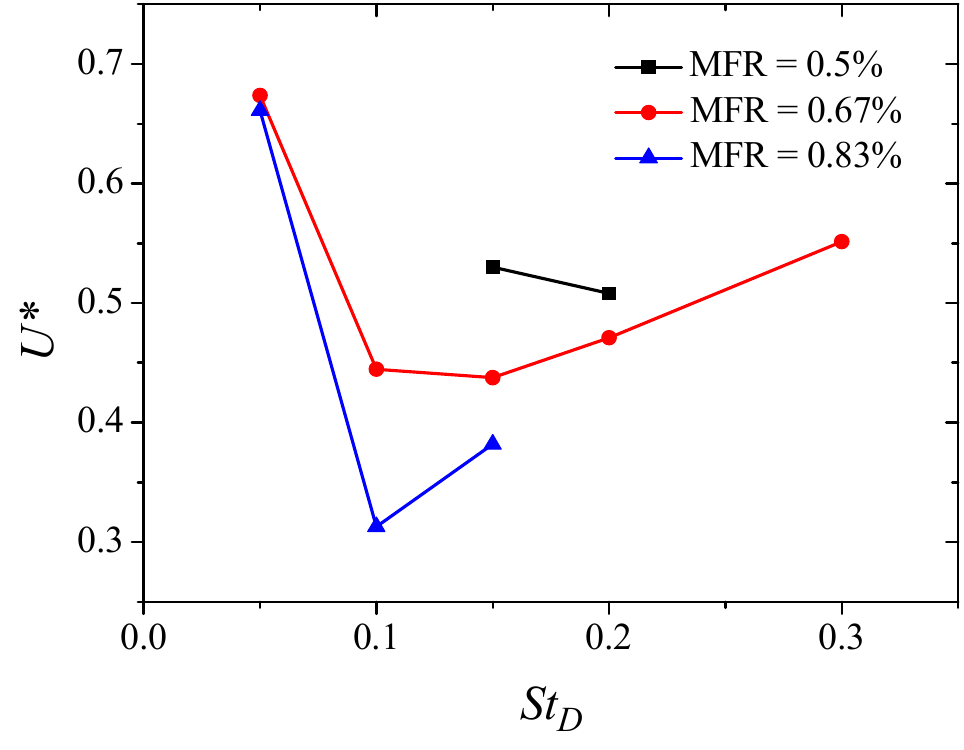
Figure 21. Velocity decay metric U * versus frequency for different amplitudes.